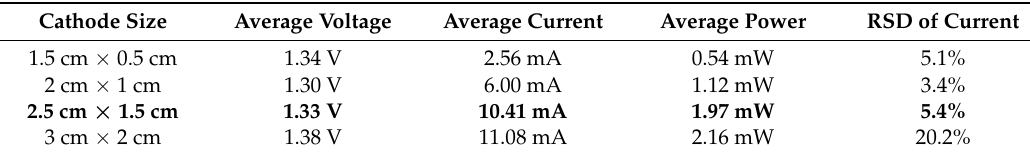
Table 5. Voltage, current, and power of a 9 cm 2 (3 cm × 3 cm) chip with varying cathode area